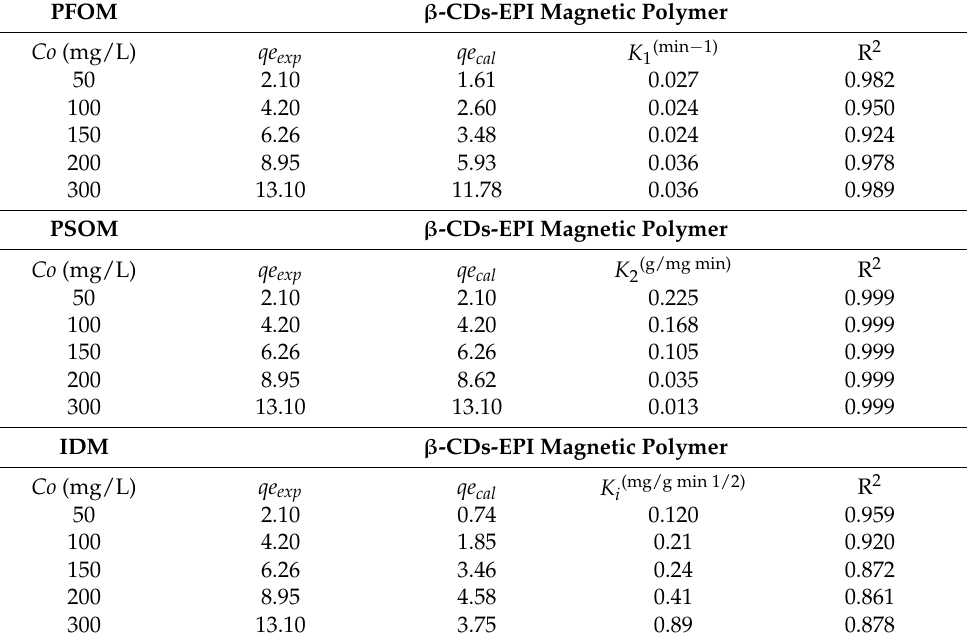
Table 1. The kinetic results (pseudo-first, pseudo-second, and intraparticle diffusion models) for the β -CD-EPI-Fe